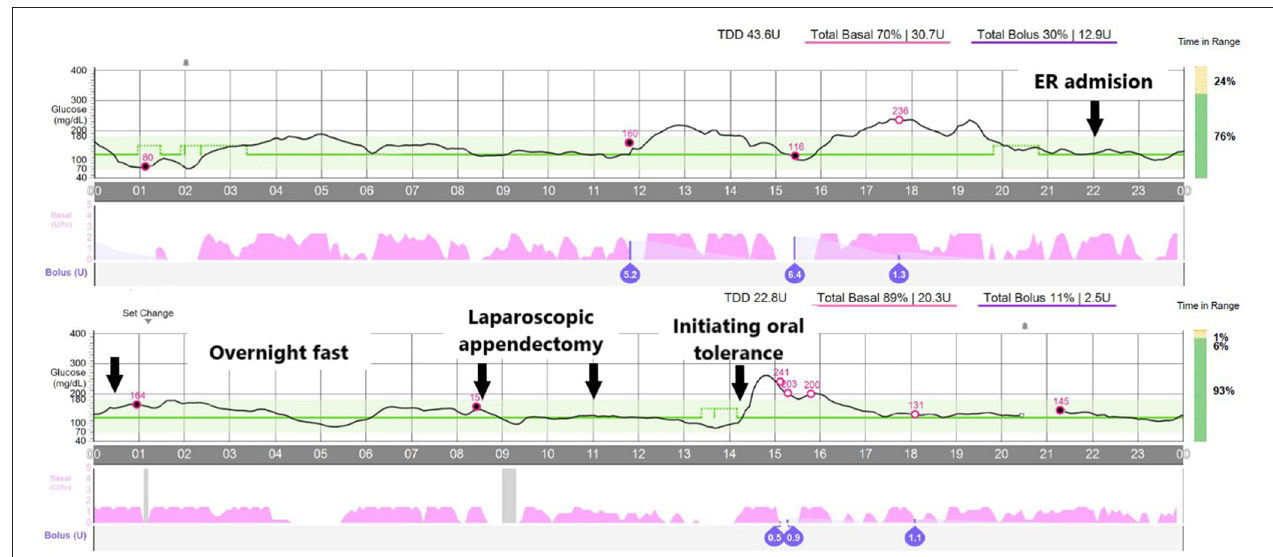
FIGURE 2 | Overview of the glucose levels along the episode. Arrows point to the following events: (1) admission at the emergency room, (2) overnight fast, (3 and 4) laparoscopic appendectomy, and (5) initiating oral tolerance. Open circles reflect blood glucose calibrations.